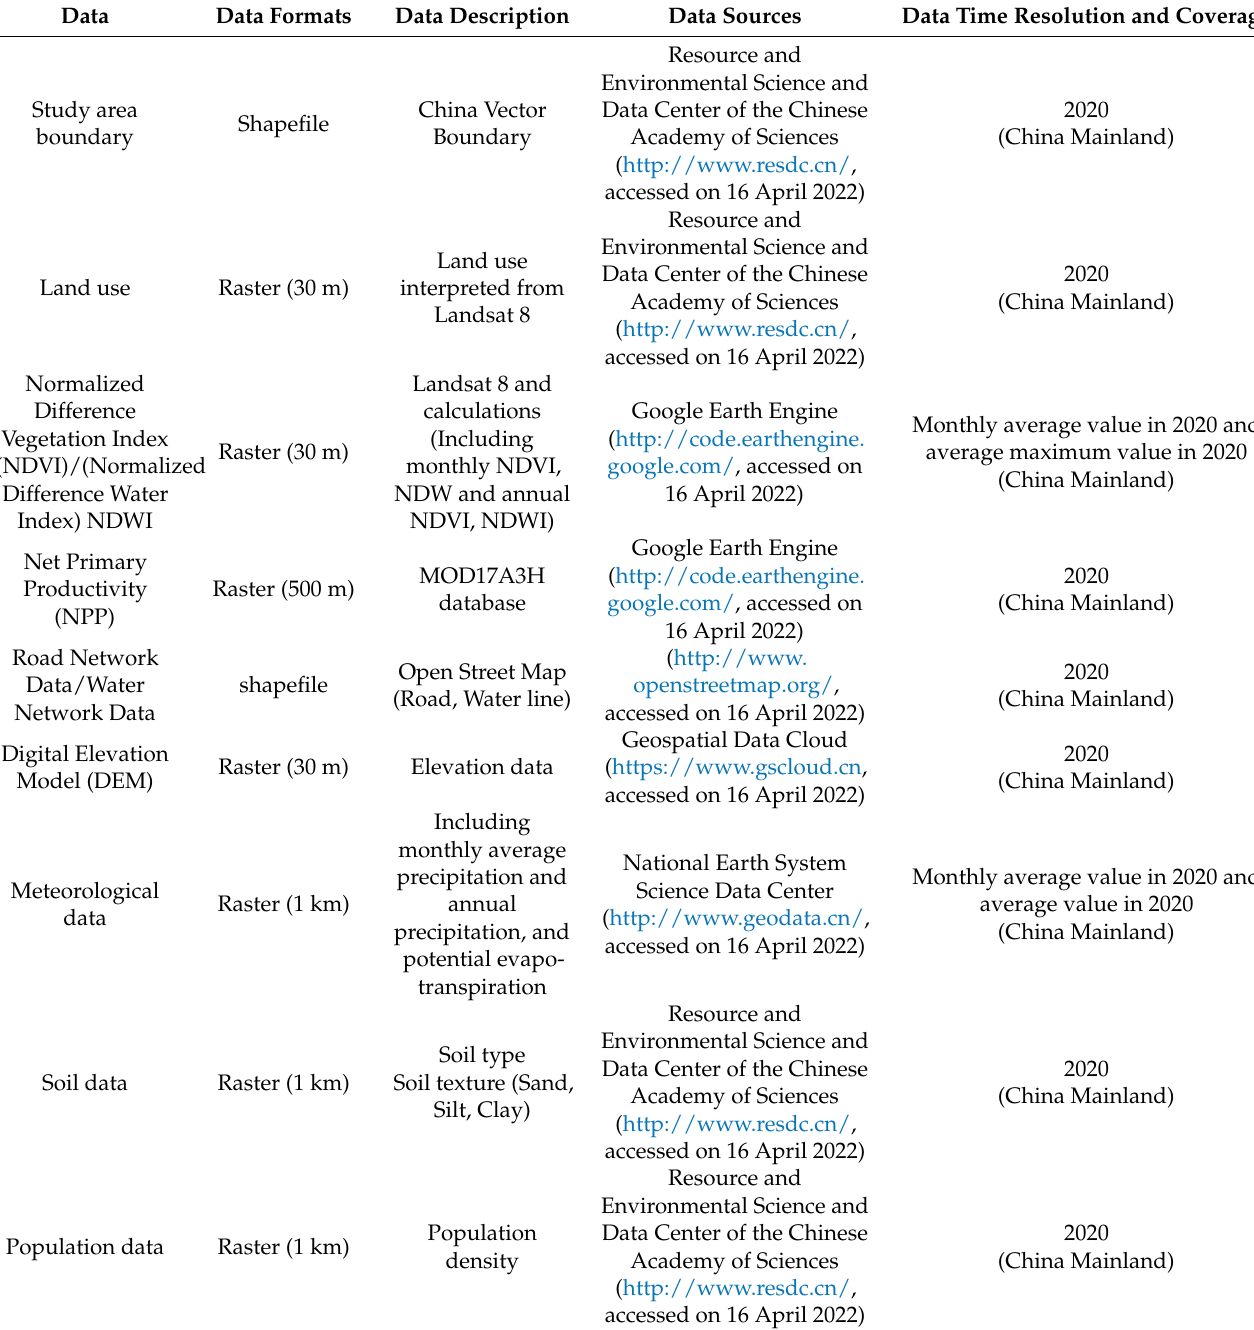
Table 1. List of